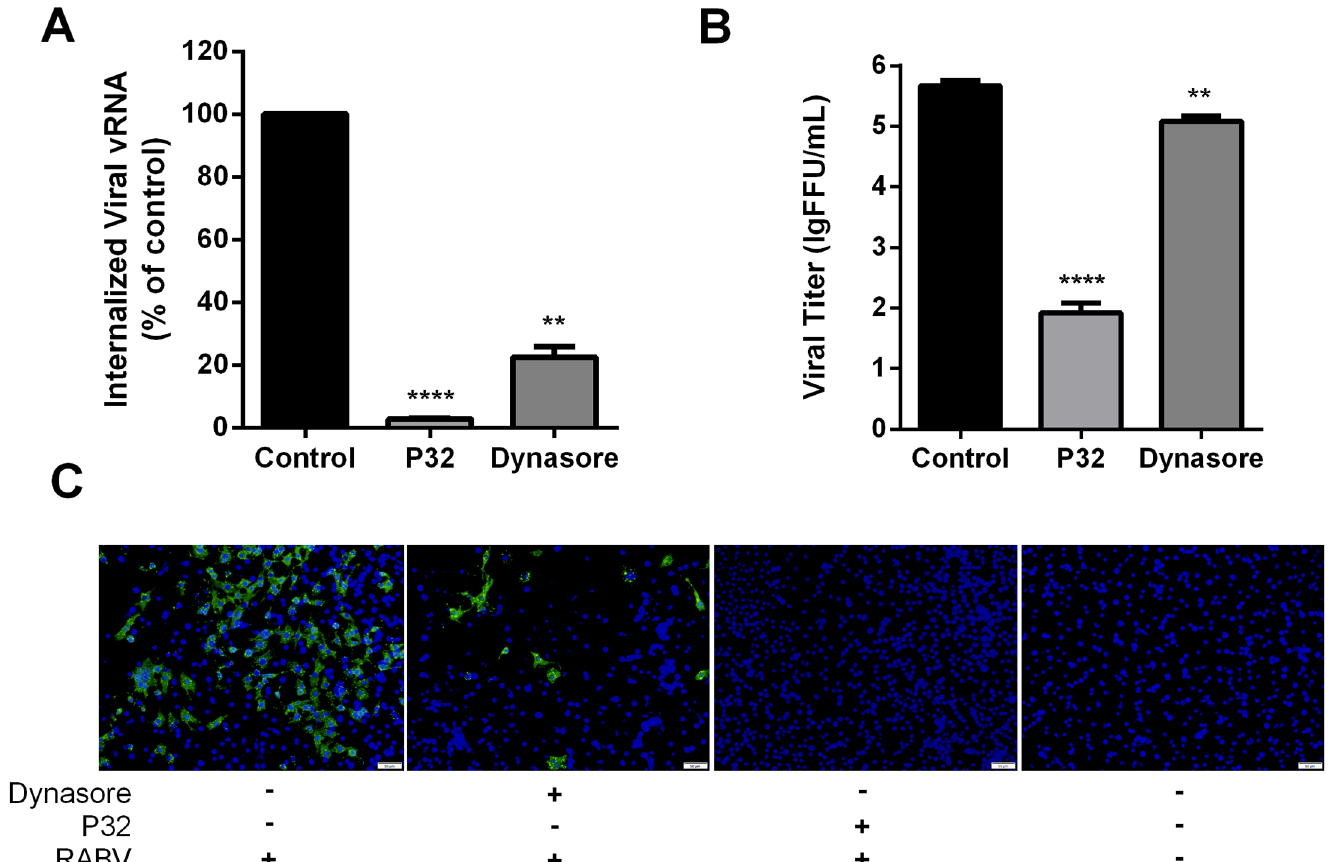
Fig 5. P32 inhibits RABV infection by interfering with viral internalization. (A) RNA levels of internalized RABV. SK-N-SH cells were infected with SAD- eGFP at an MOI of 5 and subjected to the viral endocytosis assay. Total RNA was extracted using TRIzol, and the amount of internalized viral RNA was determined by qRT-PCR. (B) Virus titer and (C) expression of RABV N protein after viral internalization with the addition of P32 or dynasore. For virus titer determination, BSR cells were infected with SAD-eGFP at an MOI of 0.01, and the viral endocytosis assay was performed as described in the Methods. Supernatants were harvested for virus titration. Each value is expressed as the mean ± SEM from three independent experiments ( * , P < 0.05; ** , P < 0.01; *** , P < 0.001; **** , P < 0.0005). For the detection of RABV N protein, BSR cells were subjected to the viral endocytosis assay, 48 hours after which, an immunofluorescence assay was conducted. A fluorescence microscope was used to observe the RABV N protein (apple green), and the nuclei were stained with DAPI (blue). The scale bar represents 50 μ